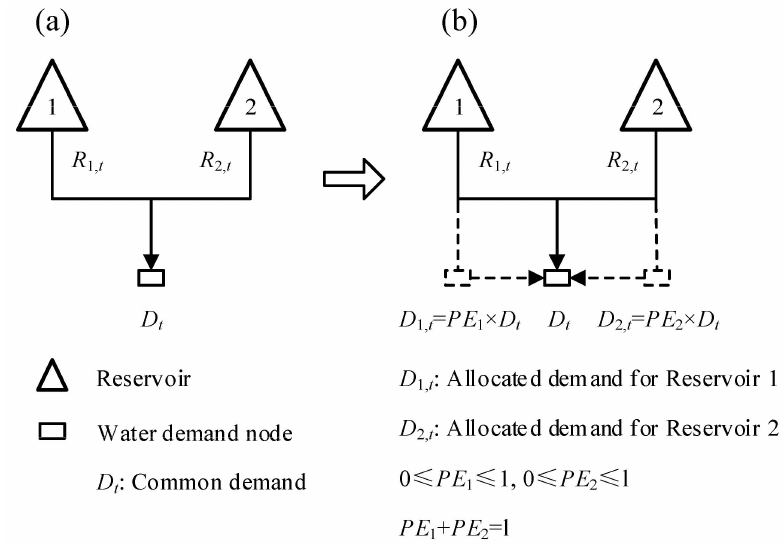
Figure 2. ( a ) The parallel two-reservoir system; ( b ) allocation policy of common water